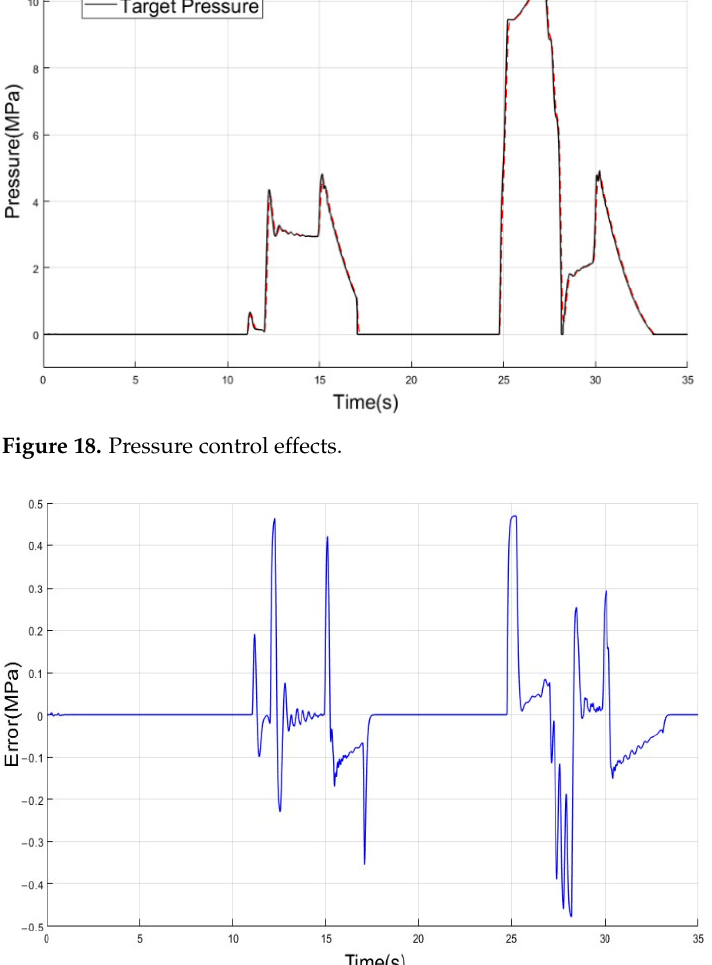
Figure 19. Pressure control error.